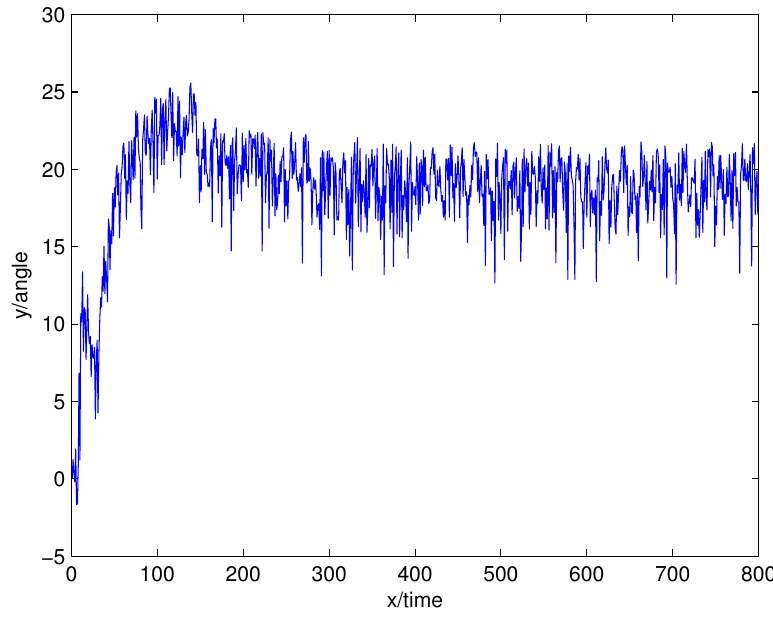
Figure 11. The original gyro